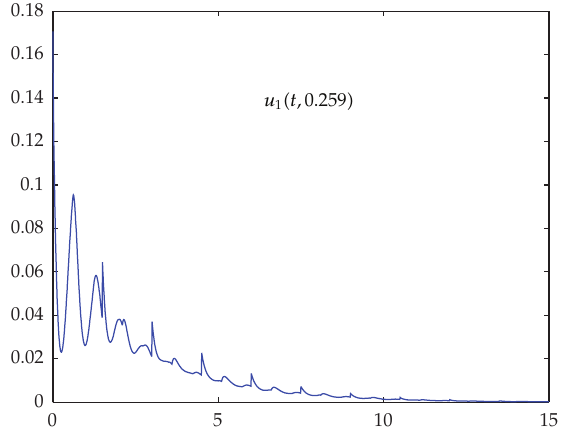
Figure 2: Sectional curve of the state variable u 1 (cid:3) t,x (cid:4)